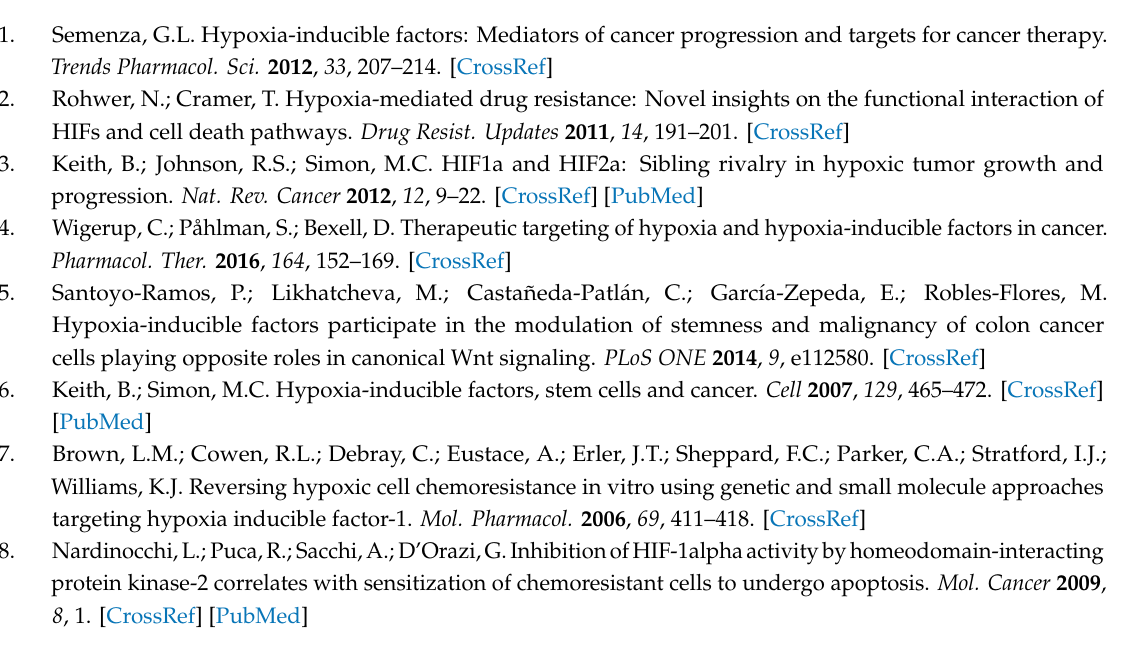
Figure S1: The expression of several autophagy marker proteins was analyzed in colon cell lines by Western blot, Figure S2: SW480 cells were stable transfected with the control scrambled shRNA plasmid, with HIF-1 α RNAi (panel A), or with HIF-2 α RNAi (panel B), Figure S3: The mTOR inhibitor CCI-779 and the chemotherapeutic drug 5-FU decrease cell viability in a dose- and time-dependent manner, but the autophagy flux inhibitor HCQ did not show cytotoxicity at any dose tested, Figure S4: SW480 or RKO cells were grown in the absence (Ctr) or presence of di ff erent doses of 5-FU, HCQ, or CC1-779 as indicated in the Figure, during 48 h, Figure S5: 19739-11K cells and OMCR14-015TK cells displayed resistance against 5-FU treatment (A), whereas OMCR15-045TK (B) displayed resistance to both 5-FU and